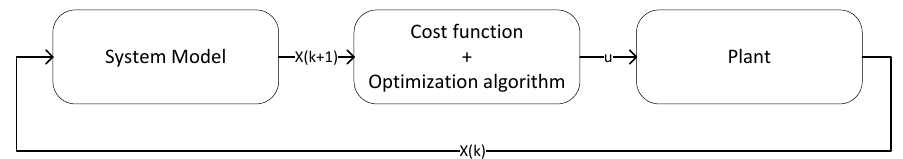
Figure 1. Model predictive control